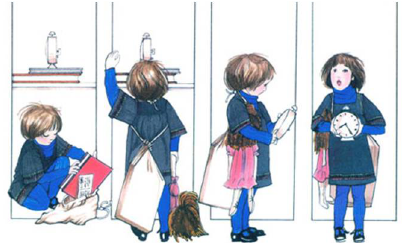
Figure 5. Ormerod J., Sunshine ; Frances Lincoln, Inghilterra 2005, [5].